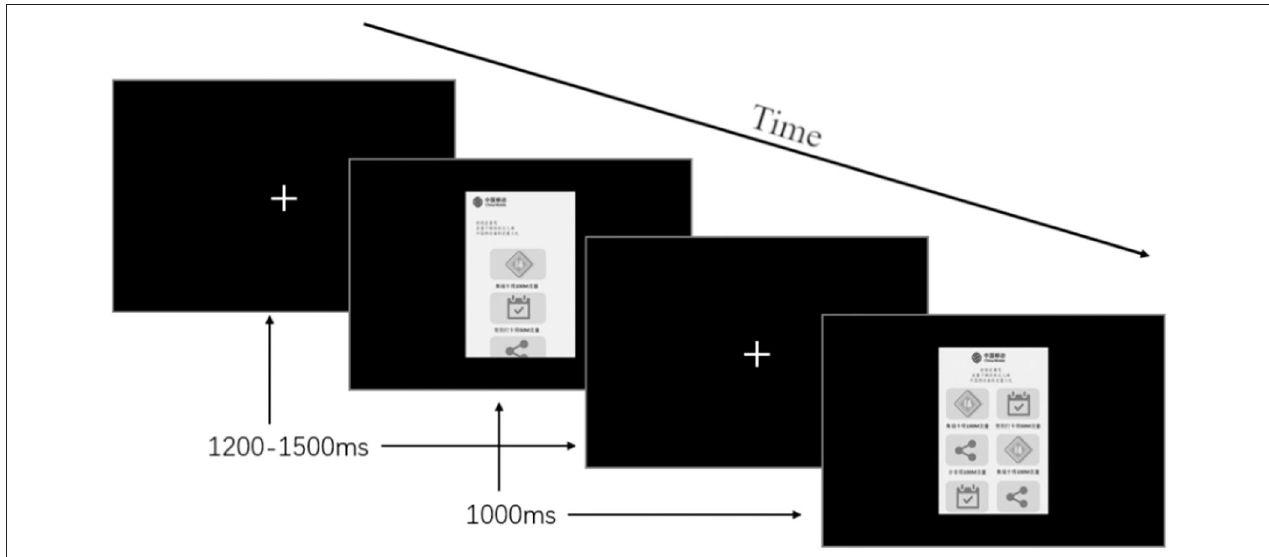
FIGURE 3 | The trial sequence. Two trials with different stimuli. A focus “+” appears at the center of the display for 1,200–1,500 ms randomly and then the stimulus appears for 1,000